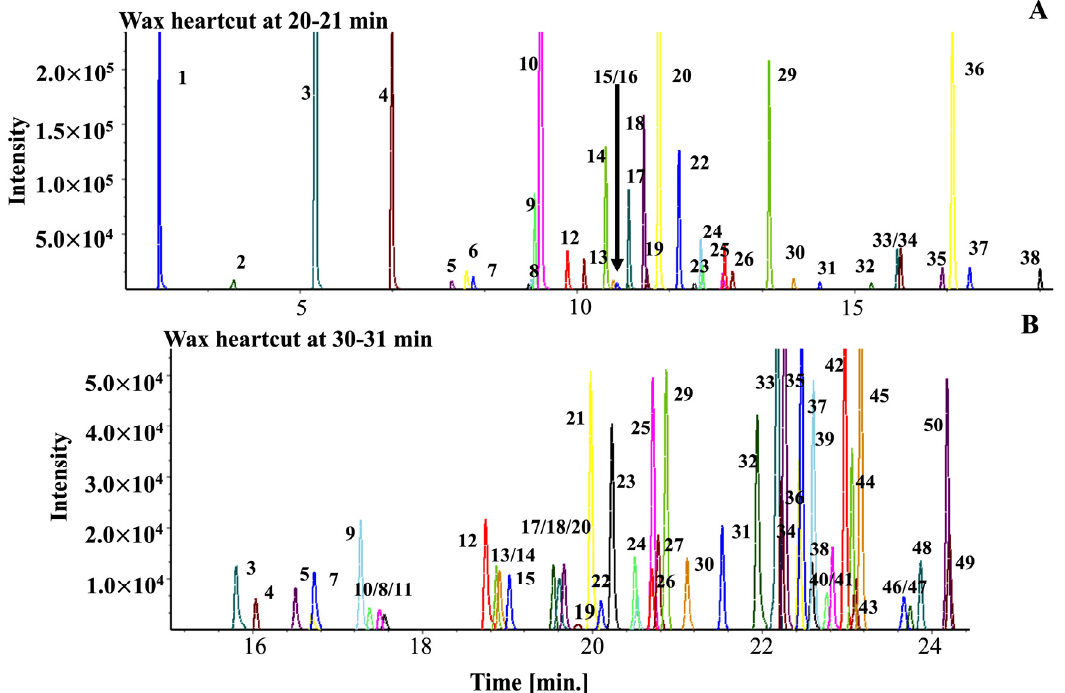
Figure 2. Sample GC-GC/MS total ion chromatograms of 1-min sample fractions transferred from the polar phase column (RTX-WAX) to the non-polar column (RTX-5MS). ( A ) Total ion current chromatogram collected from a heart cut at minute 20–21. ( B ) Total ion current chromatogram collected from a heart cut at minute 30–31.